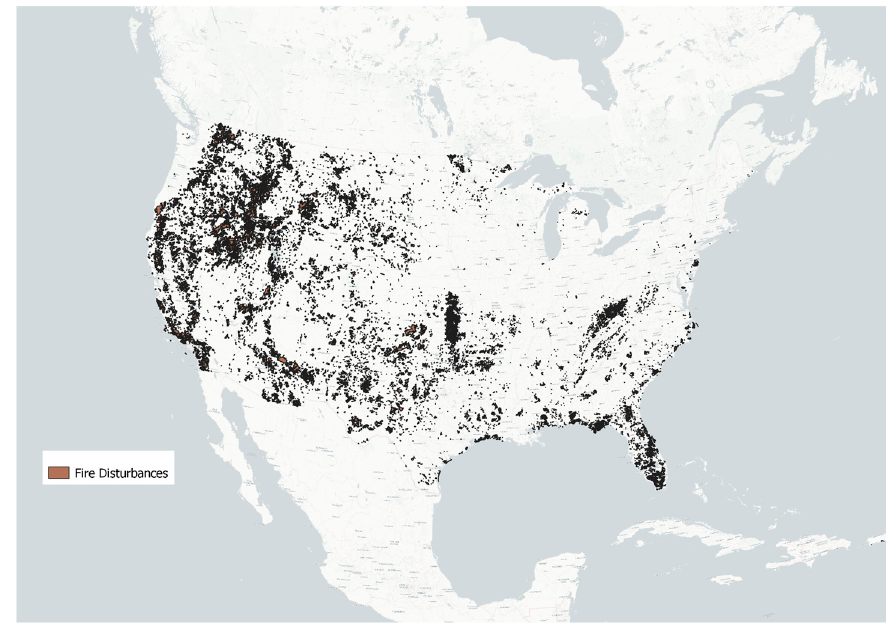
Figure 2. Disturbances: locations of updated canopy and surface fuels.